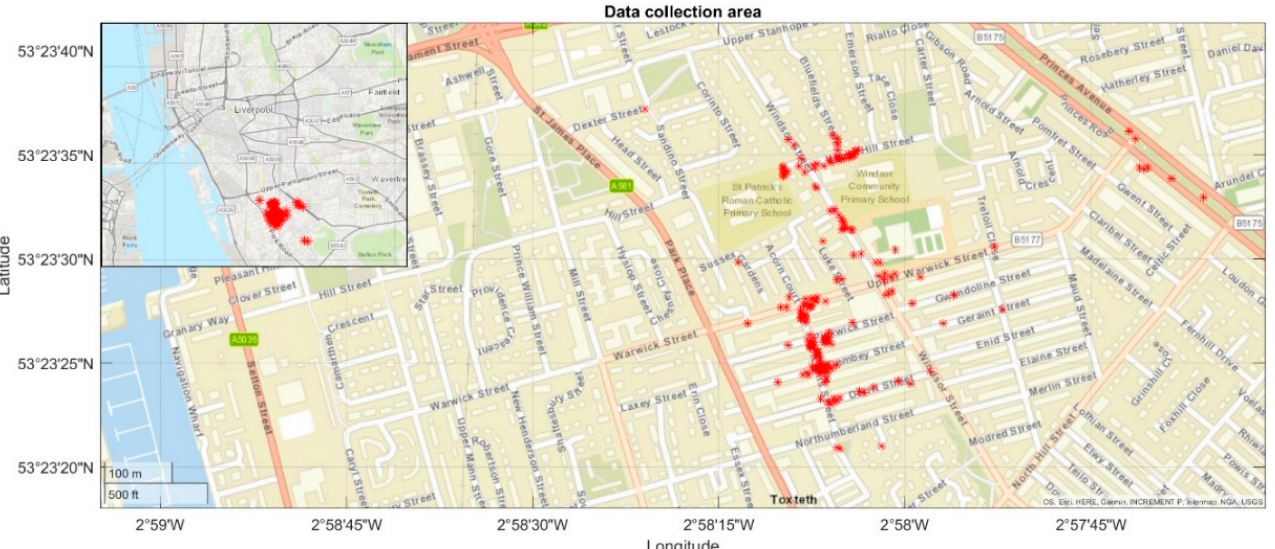
Figure 1. Project workflow.